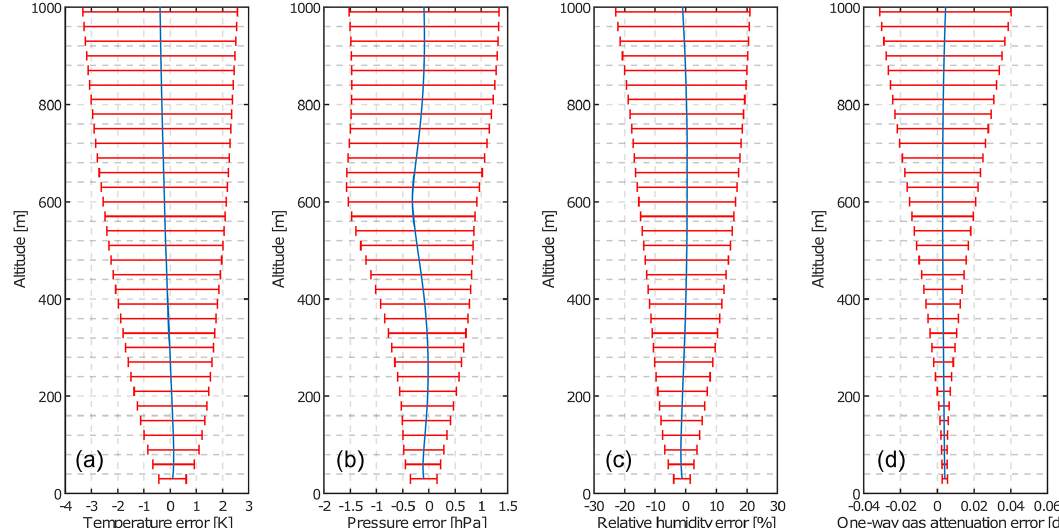
Figure A1. Uncertainties in the derived profiles of temperature (a) , pressure (b) , relative humidity (c) , and one-way gas attenuation (d) when using only surface values from a weather station. The uncertainties have been estimated with a large set of radiosonde profiles restricted to a minimum surface relative humidity of 65%. The blue lines and the red bars show mean and ± 1 standard deviation of the corresponding difference, respectively.